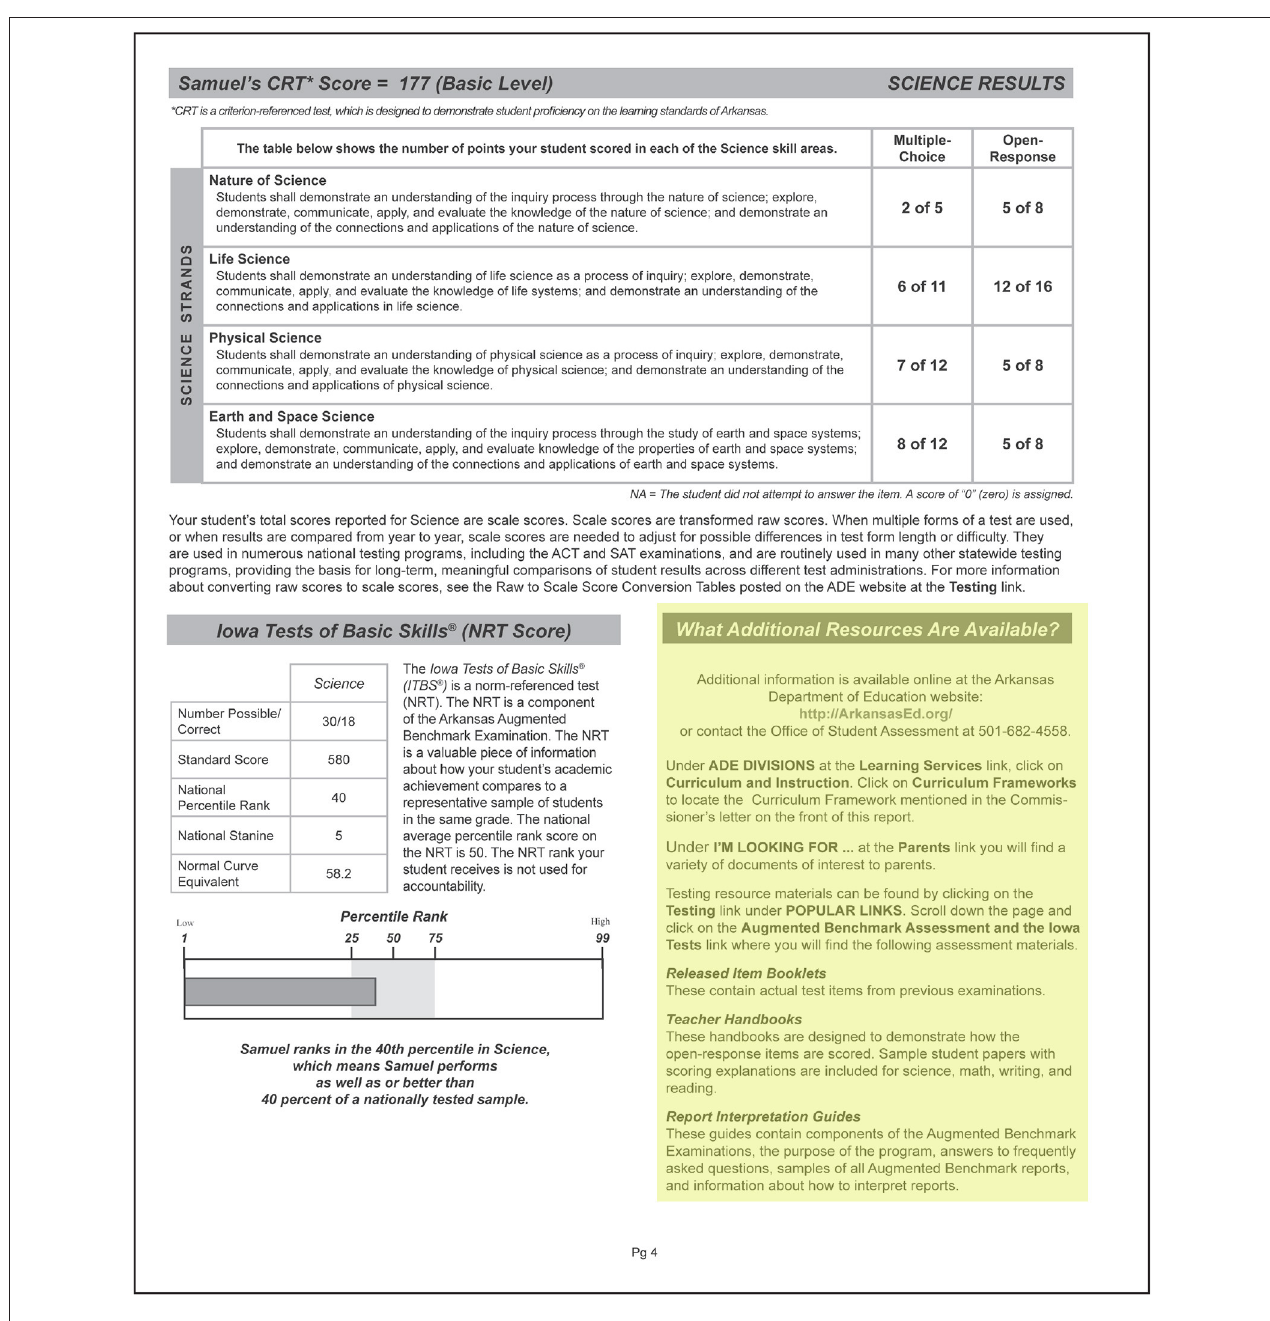
FIGURE 6 | The Arkansas report placed a section on additional resources for the parent (highlighting added) in the bottom corner of the last page. Used by permission of the Arkansas Department of Education. Iowa Tests of Basic Skills ® (ITBS ® ). Copyright © by the University of Iowa. Used by permission of the publisher, Houghton Mifflin Harcourt Publishing Company. All rights